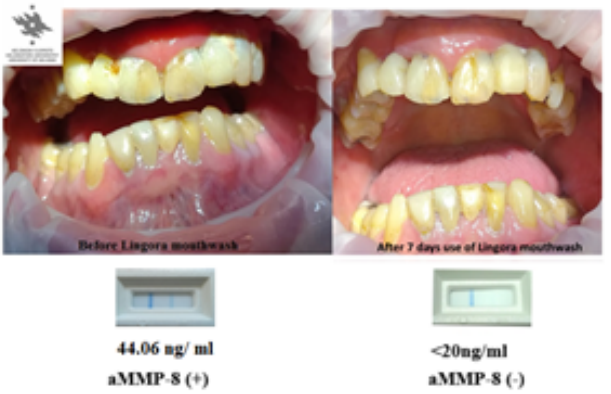
Figure 4. Photographs from one patient from group 2. (On the left before Lingora ® mouthwash; on the right 7 d after Lingora ® mouthwash). Below the photographs the PerioSafe ® chair-side test results (0 d, 7 d); two lines indicate positive (+, 44.06 ng/mL) and one line (−, < 20 ng/mL) negative test outcomes.